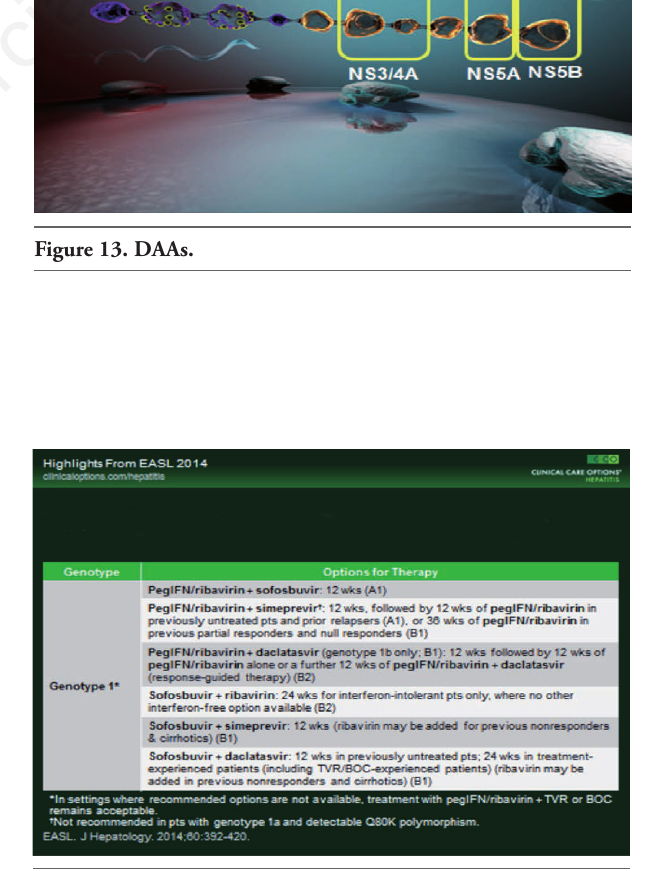
Figure 14. EASL HCV guidelines 2014: Genotype